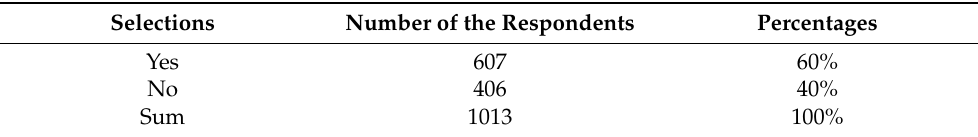
Table A20. Do you think that holdings of cryptocurrencies will become legal in the future in China (single-choice